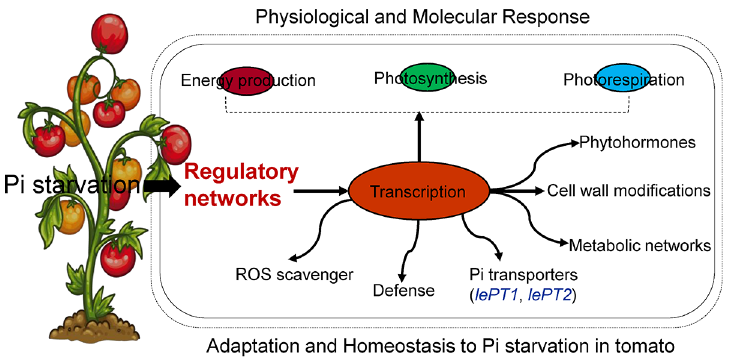
Fig 6. Schematic model and systematic pathway to Pi starvation, its tolerance and homeostatic mechanisms in tomato plants. Pi starvation affects the cellular processes like energy production, photosynthesis, photorespiration, and various metabolic pathways (transcription/translation) whereas, the regulatory pathways to defend Pi starvation for tolerance and its homeostasis were regulated in tomato plants as described in our proteome data and transcript